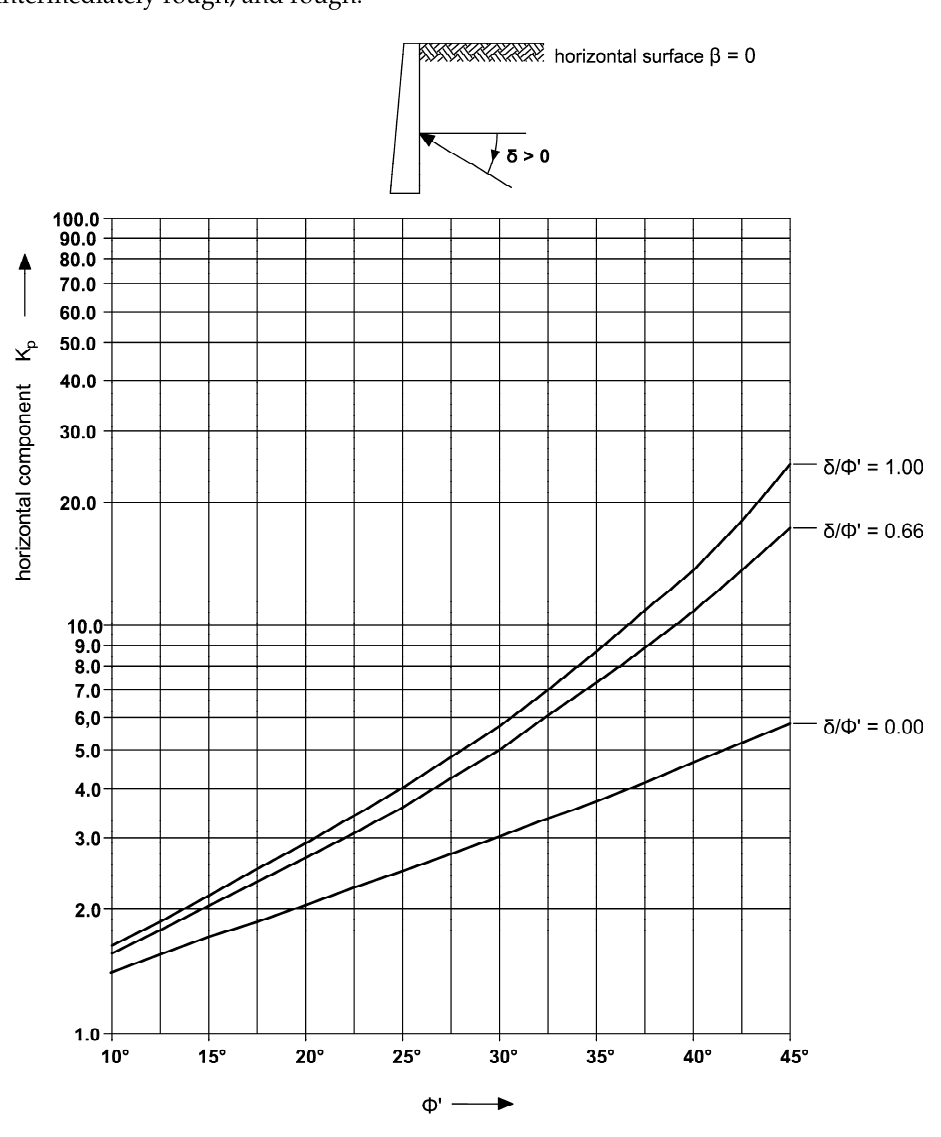
Figure 2. Coefficients K p of effective passive earth pressure (horizontal component): with horizontal retained surface ( β = 0). Reprinted with permission from ref. [28]. 2008 Polish Committee for Standardization.